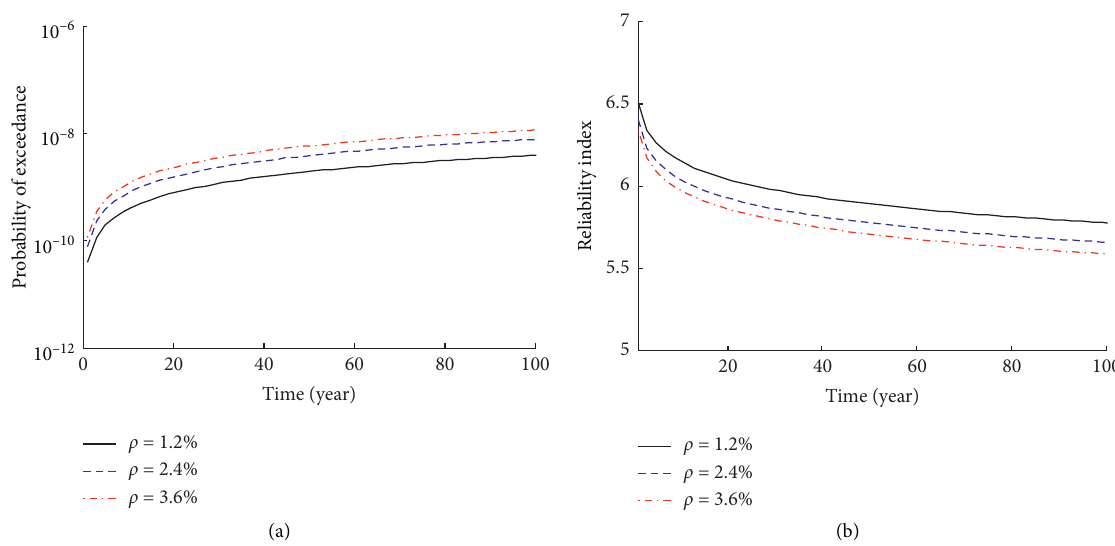
Figure 16: Reliability index of the continuous rigid-frame bridge based on the first-passage criterion of the girder deflection: (a) failure probability; (b) reliability